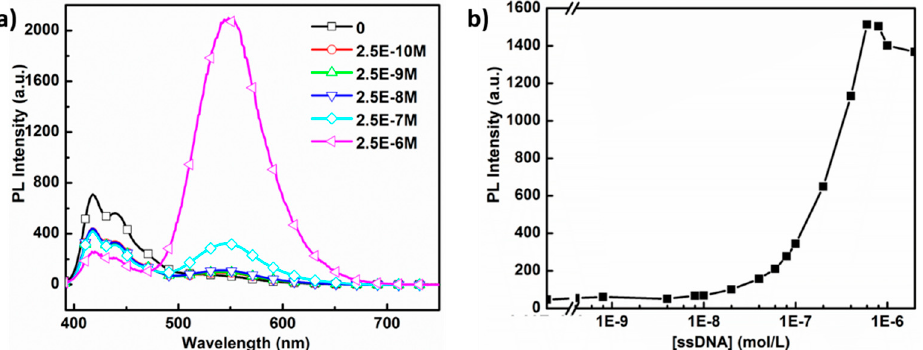
Figure 4. ( a ) PL spectra of PFC3NBT after addition of ssDNA at adverse concentrations; ( b ) fluorescence intensity at 545 nm in the presence of ssDNA at adverse concentrations ((RU) of PFC3NBT = 4.5 µ M, excitation at 380 nm).